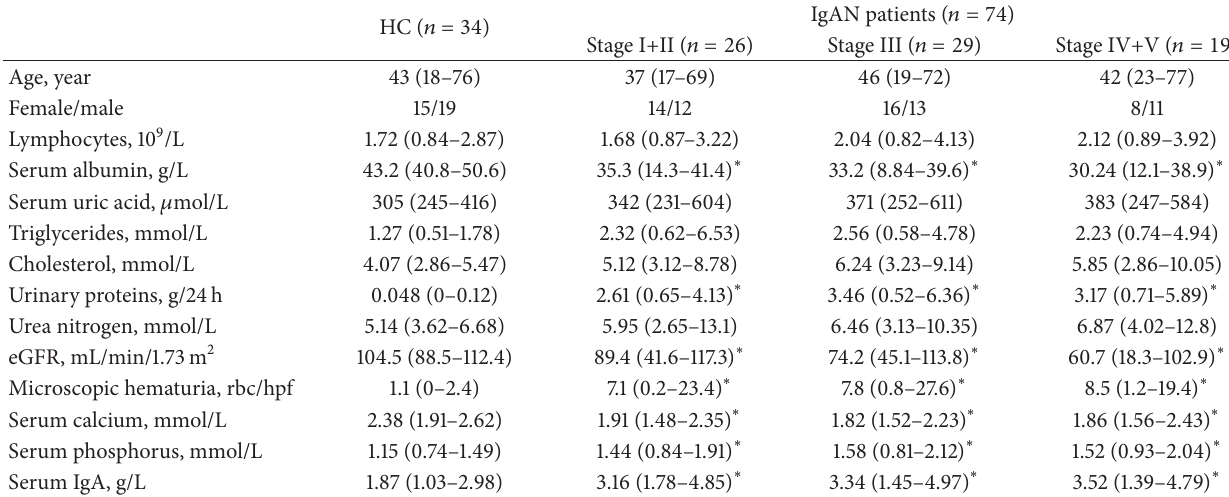
Table 1: Demographic and clinical characteristics of